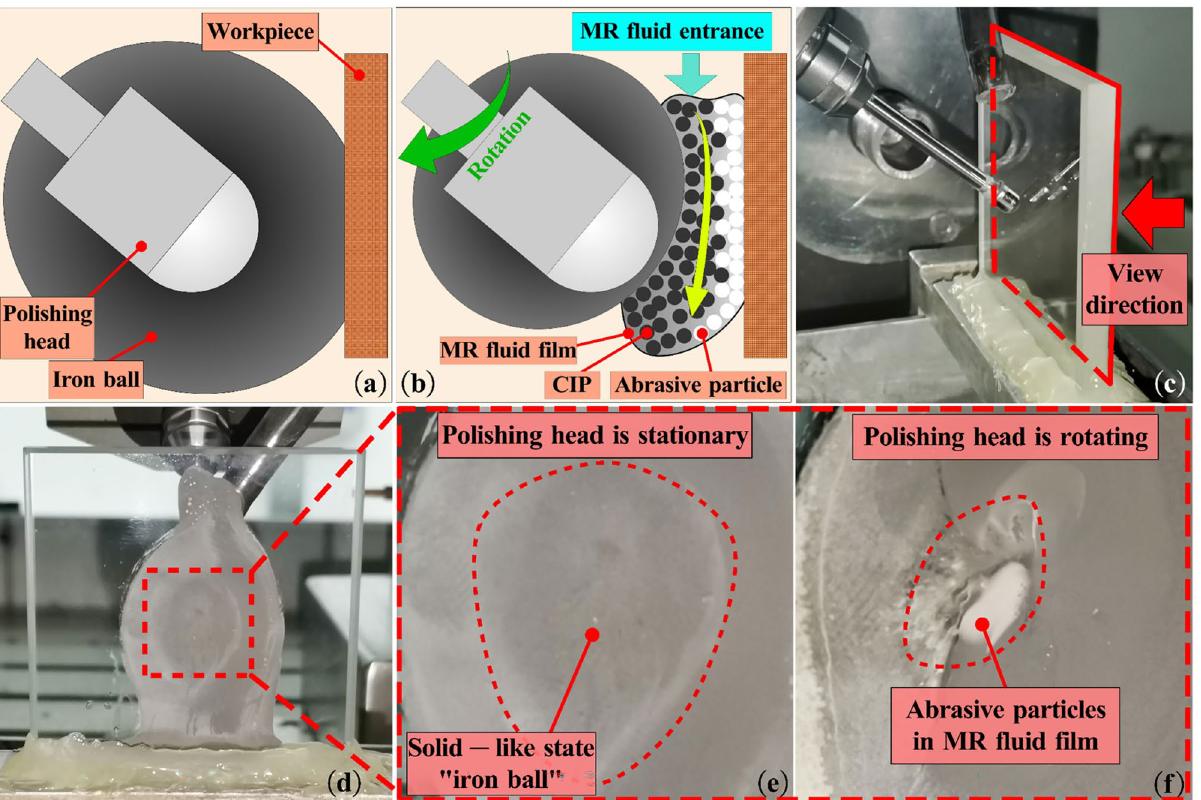
Figure 1. Schematic diagram of material removal mechanism. ( a ) Polishing zone when the polishing head is stationary; ( b ) Polishing zone when the polishing head is rotating; ( c ) View direction; ( d ) Back of workpiece surface; ( e ) Iron ball with solid-like state; ( f ) MR fluid